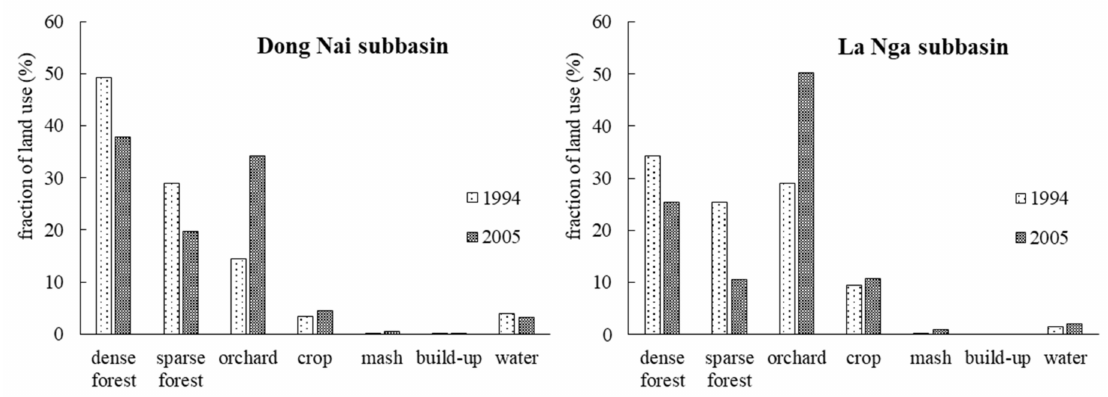
Figure 7. Fraction of land uses in Dong Nai and Ta Lai river subbasins in 1994 and 2005 (calculated from